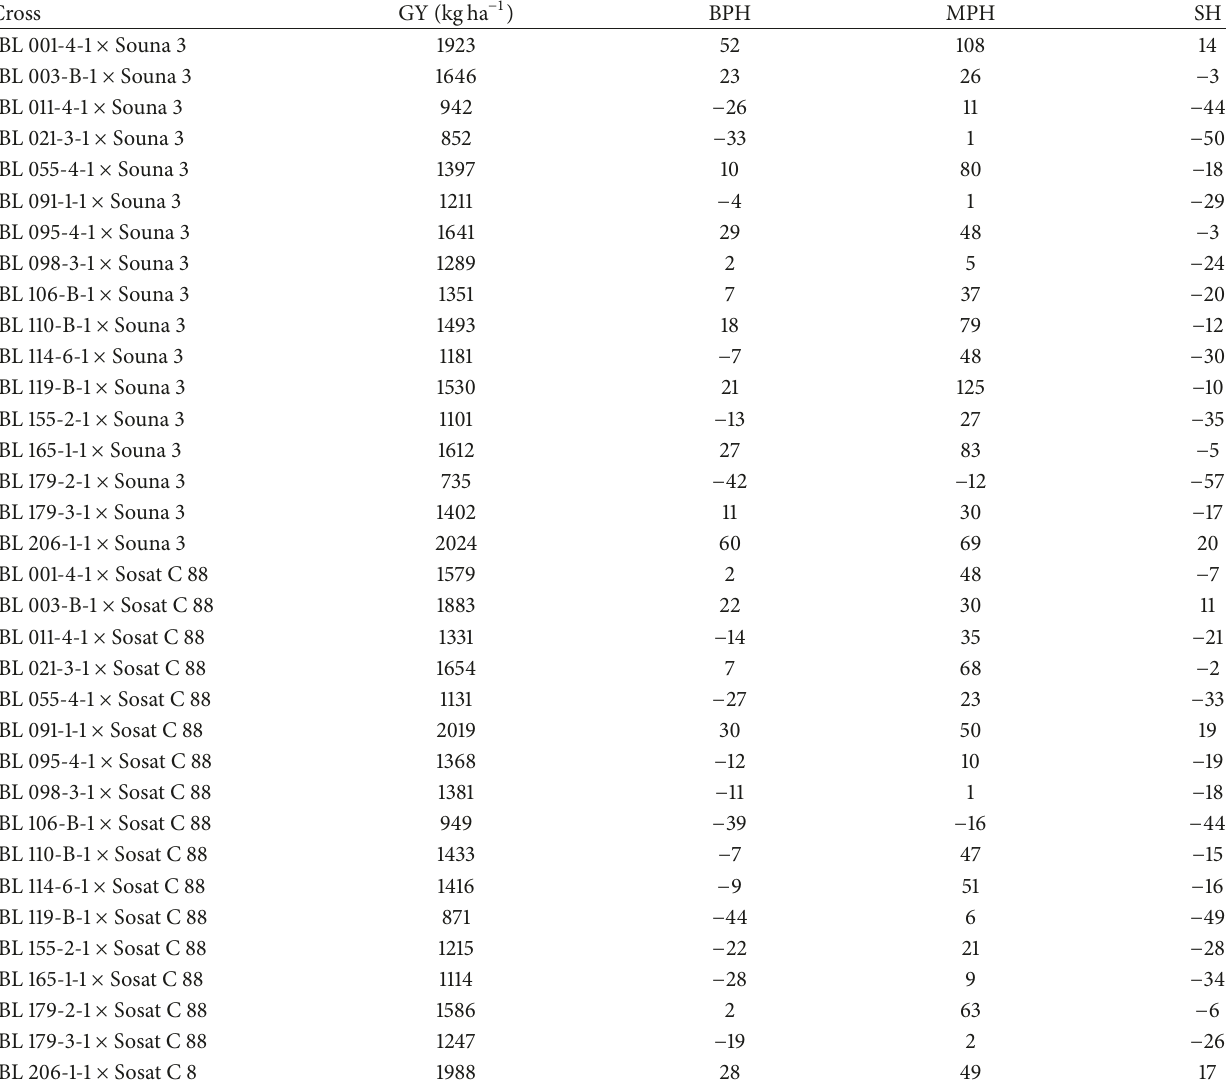
Table 8: Mean grain yield and best and mid-parent heterosis of pearl millet hybrid across locations.